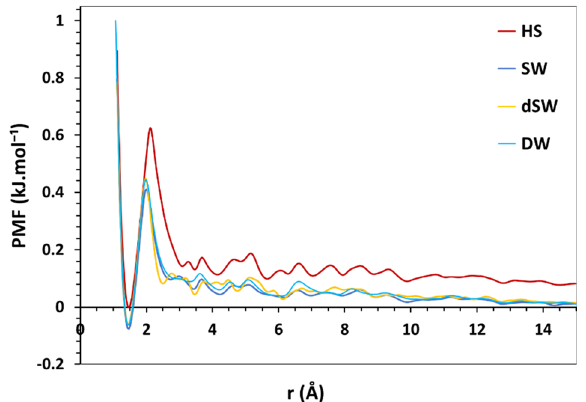
Figure 9. Potential of mean force curve for the adsorption of BA molecules onto